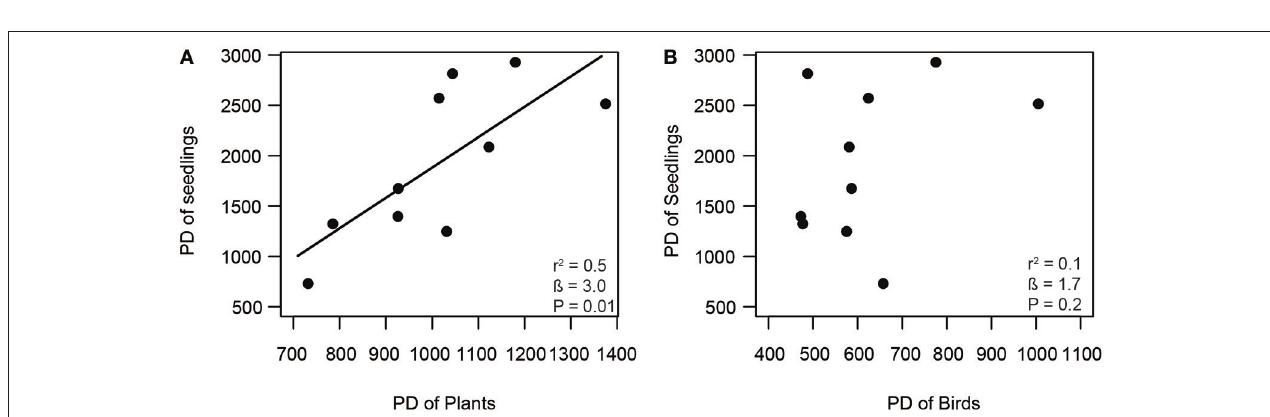
FIGURE 2 | Positive relationship between (A) phylogenetic diversity (PD) of fleshy-fruited plants and PD of seedlings, and lack of a relationship (B) between PD of birds and PD of seedlings across 10 study plots in the Colombian Andes (elevational range: 1,800 m–2,700m a.s.l.). Shown are results from linear regression models. Given are the overall model fit ( r 2 ) and the estimated slope ( β ) with its associated P -value; the solid line indicates a significant trend.